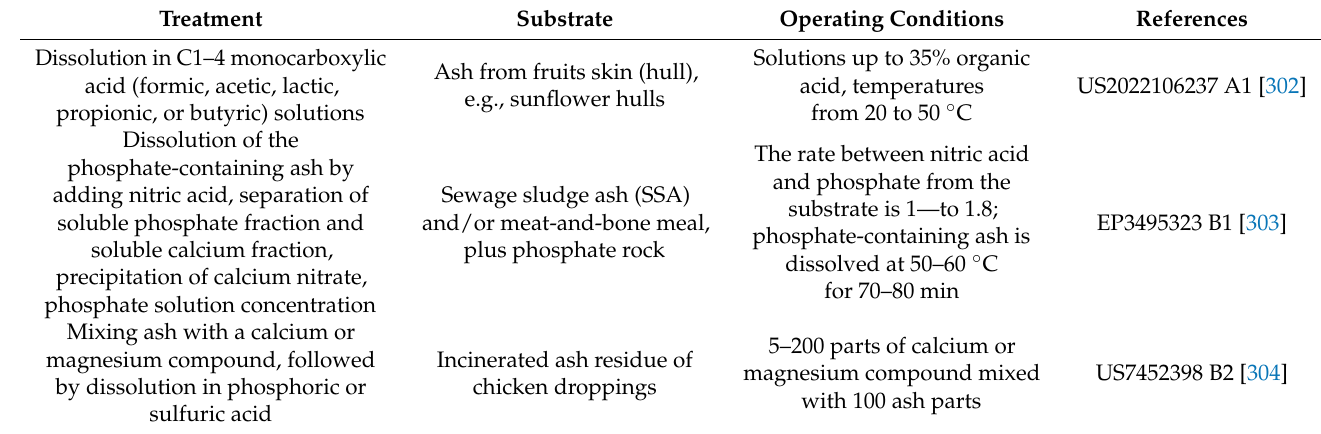
Table 4. Examples of the patented solutions for producing phosphate fertilizers from biomass